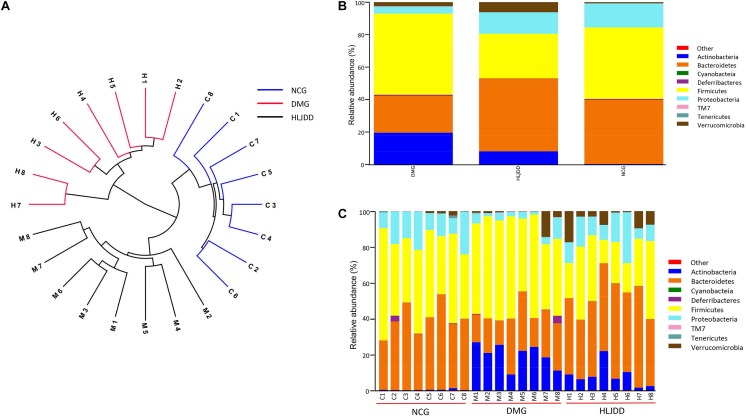
Comparison of the feces microbial community among three groups. (A) Multivariate analysis of variance from unweight UniFrac-based PCoA matrix scores. (B) Bacterial taxonomic profiling in the phylum level of gut microbiota at individual level. (C) Bacterial taxonomic profiling in the phylum level of gut microbiota based on different groups.